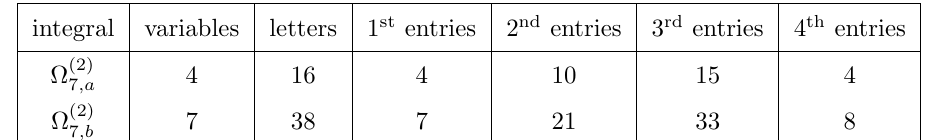
Table 2 . Summary of properties of both two-loop heptagon integrals (cid:10) (2) number of variables, the number of independent letters in total and the number of independent letters in each entry of the